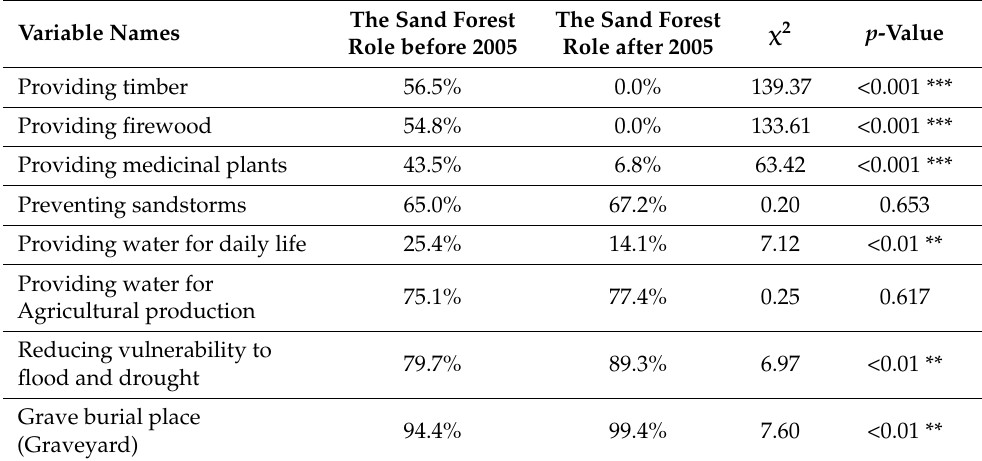
Table 3. Change in the sand forest’s roles before and after 2005 in the studied